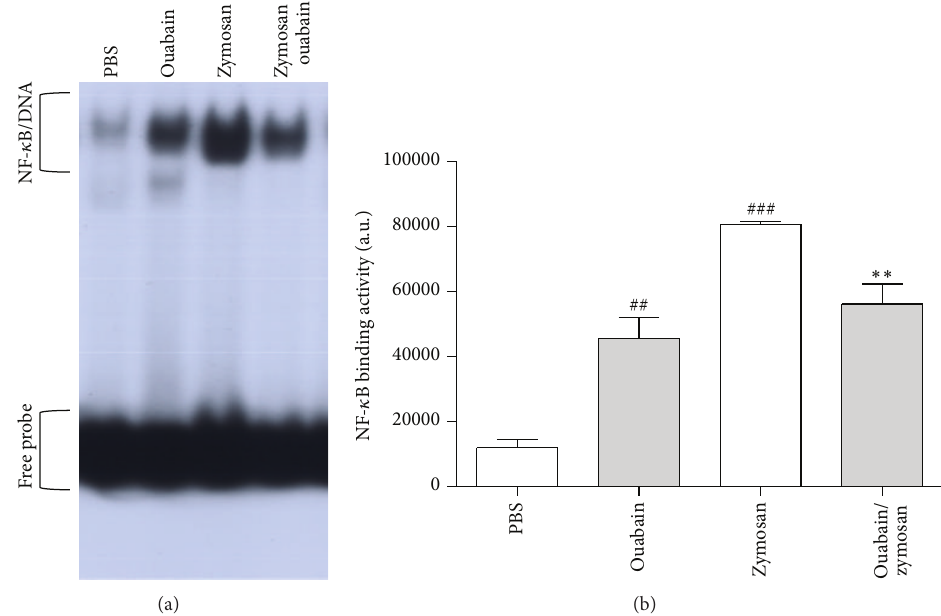
Figure 8: Ouabain reduced zymosan-induced NF- 𝜅 B binding activity. Electrophoretic mobility shift assay (EMSA) from peritoneal cells 4 h after injection with zymosan. Nuclear proteins (5 𝜇 g) were extracted from peritoneal cells after 4 h injection with zymosan or PBS. (a) Protein/DNA complexes positions are indicated by arrows (NF- 𝜅 B) and the nonspecific band (NS) is also indicated. The respective densitometric analyses (arbitrary units (a.u.)) of the NF 𝜅 B band complex presented in panel (a) are shown in graphic (b). Results were expressed as mean ± SEM and analyzed by Graphpad Prism using ANOVA with Tukey’s posttest, where all groups were compared. Results were obtained from 4 animals per group. ## 𝑃 < 0.01 and ### 𝑃 < 0.001 versus PBS group and ∗∗ 𝑃 < 0.01 versus zymosan